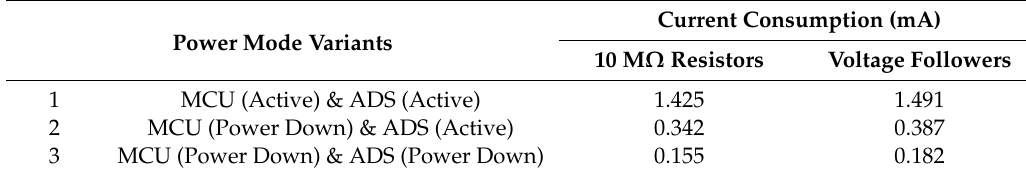
Table 1. Average current consumption. Battery voltage: 3.68